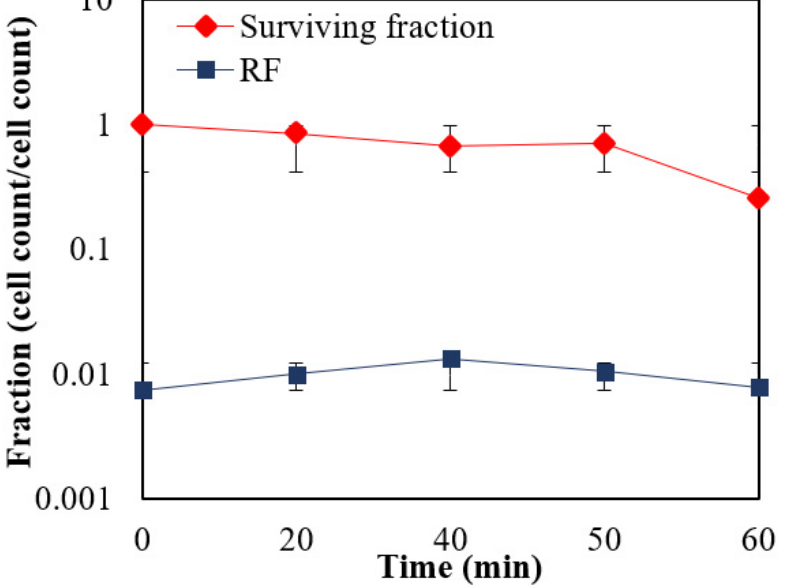
Figure 3. CbCt surviving fraction and relative frequency of induced mutation from EMS contact.